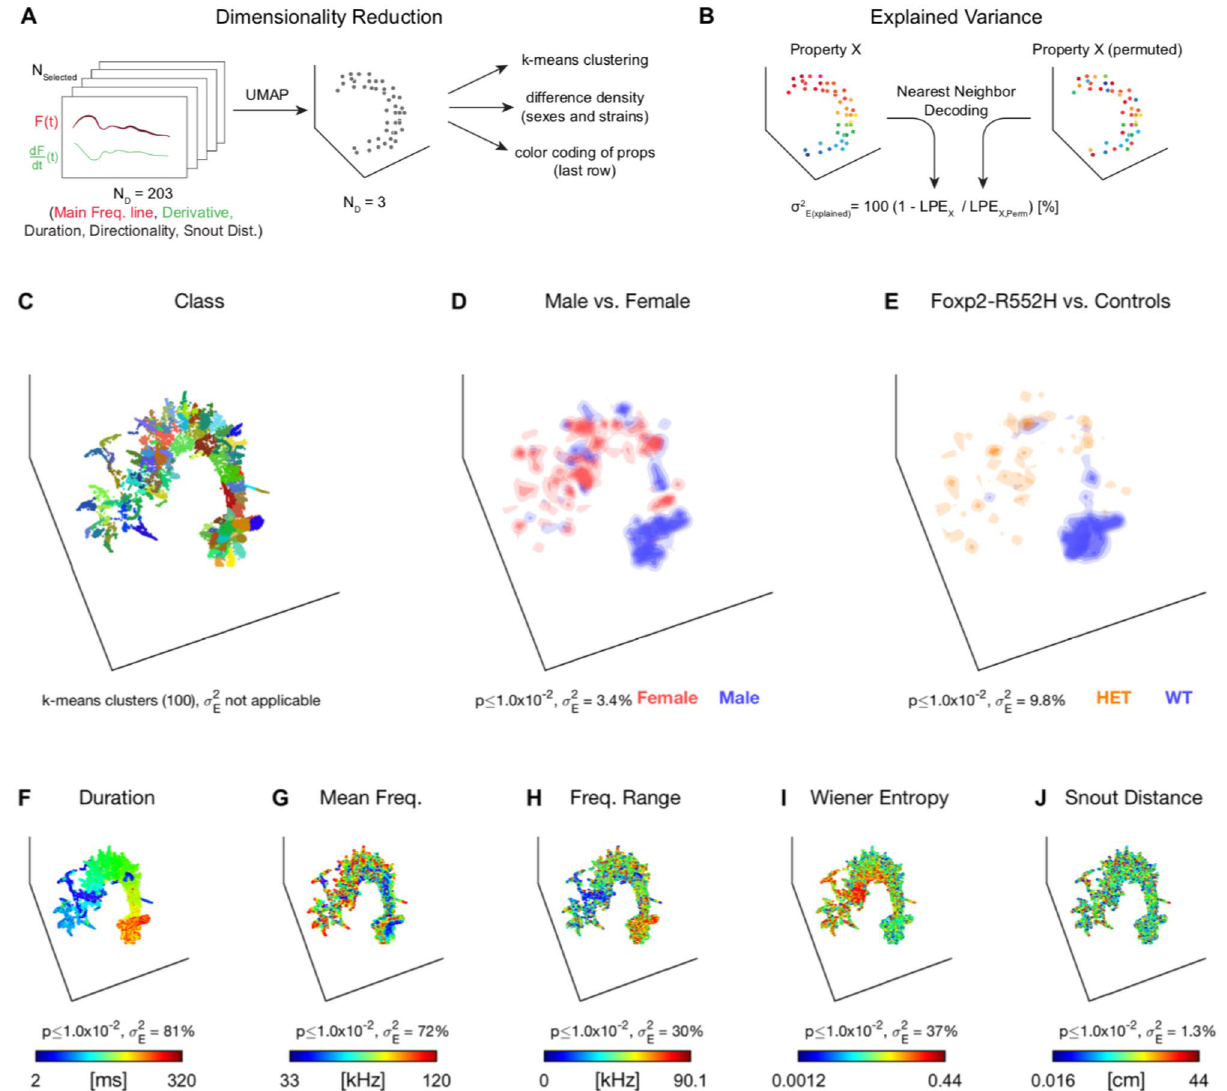
Figure 6. Dimensionality reduction of USV properties detects relations between acoustic properties, strain, sex, and relative position. Supplemental Movie 2 shows the same data revolving in 3D, resolving depth ambiguities. ( A ) Each USV was represented by its main frequency line (up to 100 ms), its derivative, the duration, the directionality in frequency, and the snout-to-snout distance (203 dimensions) and then reduced to 3 dimensions using UMAP 28 . The analysis was based on the set of selected vocalizations (see Fig. 4). The results are differently color-coded for each property. ( B ) We evaluated whether a property of the USV was related to others after dimensionality reduction by comparing the original (left) to shuffled data (right; same spatial and value distribution) using nearest neighbor decoding. This allowed us to assess the percentage of variance explained as the relation between the local prediction error (LPE, see Methods for details) of the original and shuffled data. ( C ) After dimensionality reduction, the set of spectrograms exhibited a rich structure. We highlight the richness of the substructure here by running clustering (k-means, k = 100, different colors). However, clusters are often not clearly separated but rather connected. The properties in the following panels partially clarify the origin of this substructure. ( D ) Sex showed a significant contribution to accounting for the neighborhood structure, shown here via local density differences between male and female emitters. While significant, these differences explain only 3.4% of the LPE. ( E ) The Foxp2-R552H variant (male vocalizers only) also significantly accounted for the local structure, accounting for 9.8% of the LPE. Interestingly, differences in spatial density between the strains (Foxp2-R552H: orange; WT littermate: blue) partly coincided with the sex differences in ( D ). ( F ) Among the tested properties, duration best explained the neighborhood structure of the spectrograms by being able to account for 81% of the LPE. ( G ) Mean frequency also explained a substantial part of the neighborhood structure, although largely locally ’orthogonal’ to the duration (i.e. multiple local gradients of frequency), accounting for 72% of the LPE. ( H ) Frequency range explained 30% of the LPE and appears correlated in spatial distribution with duration. ( I ) The Wiener Entropy also explained a substantial part of the LPE (37%). ( J ) Different snout-to-snout distances only made borderline significant contributions to the structuring and accounted for 1.3% of the LPE. Supplementary Figs. 5 and 6 and Supplemental Movies 3 and 4 show the same analysis when excluding duration or duration and mean